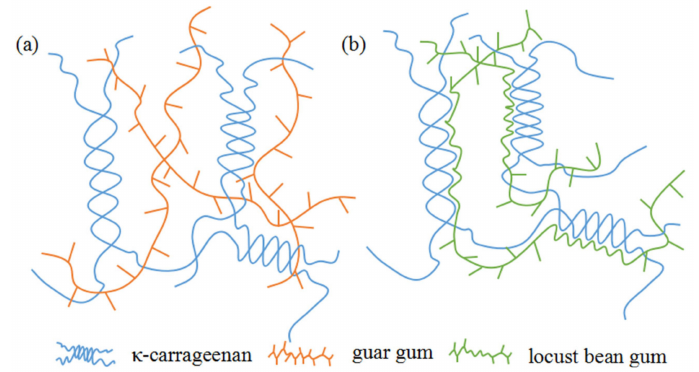
Figure 5. Binding mechanism diagram of KC g film ( a ) and KC-L film ( b